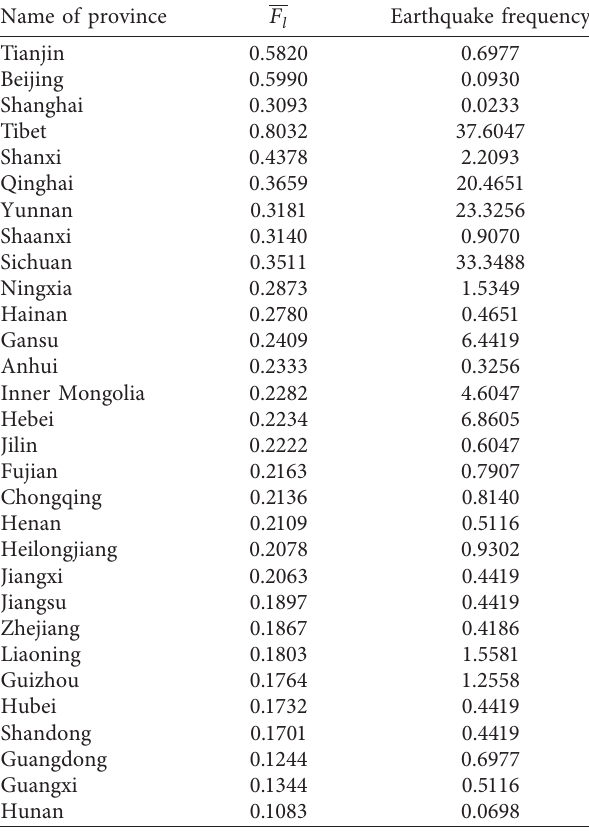
Table 1: F l and yearly earthquake frequency.